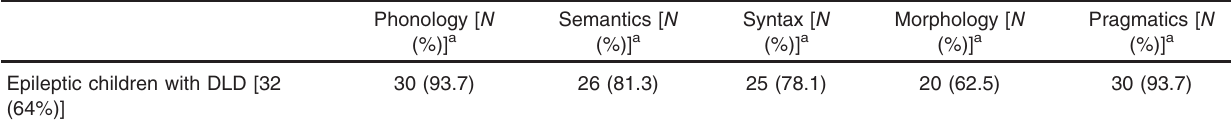
Table 6 Descriptive study of Comprehensive Arabic Language Test domains (phonology, semantics, syntax, morphology, and pragmatics) of epileptic children who had developmental language disorder